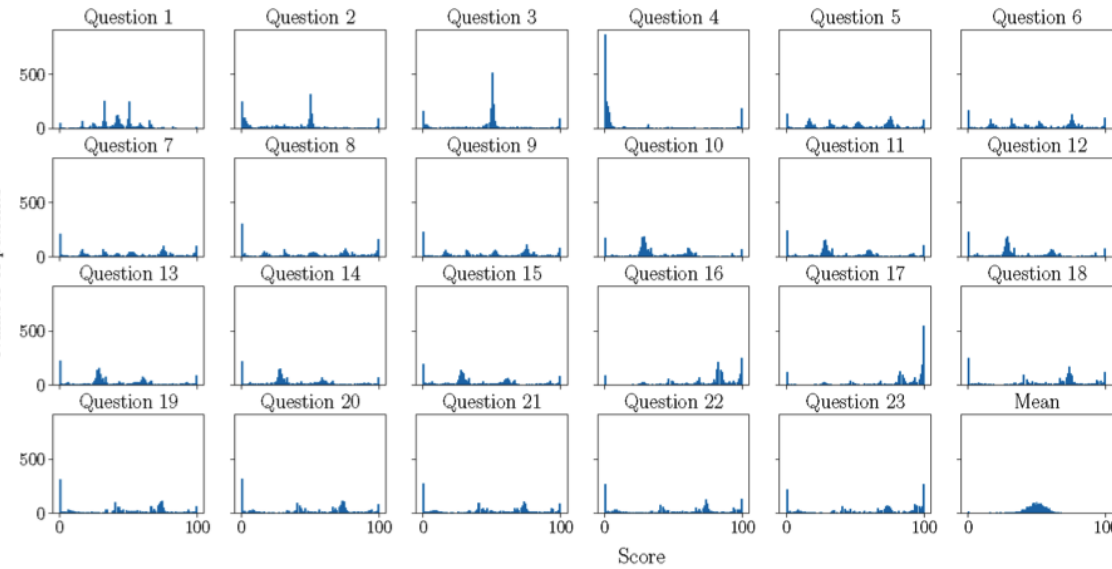
Figure 1. Histograms of scores provided by eHealth users to each of the 23 questions of the mental well-being questionnaire. Scores range from 0 to 100. The last histogram presents the average score for all